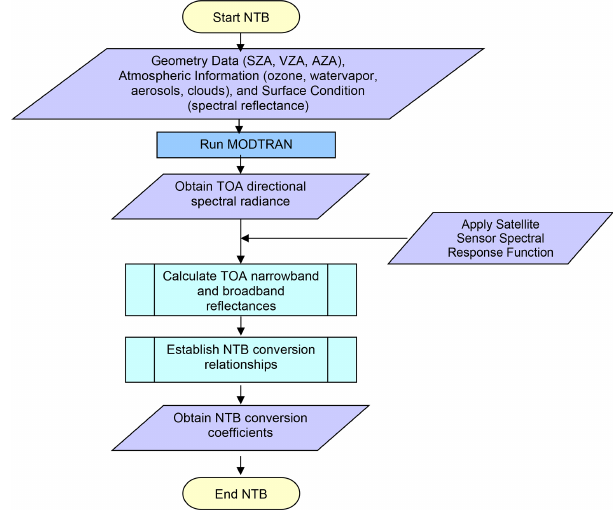
Figure 1. Flowchart of the NTB transformations illustrating the main processing sections.